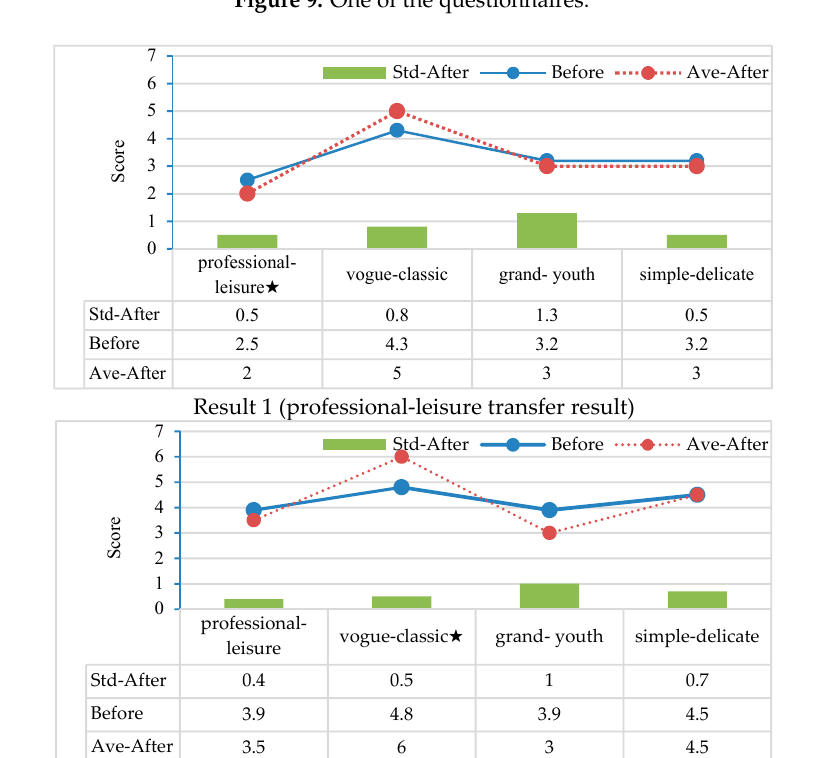
Figure 9. One of the questionnaires.